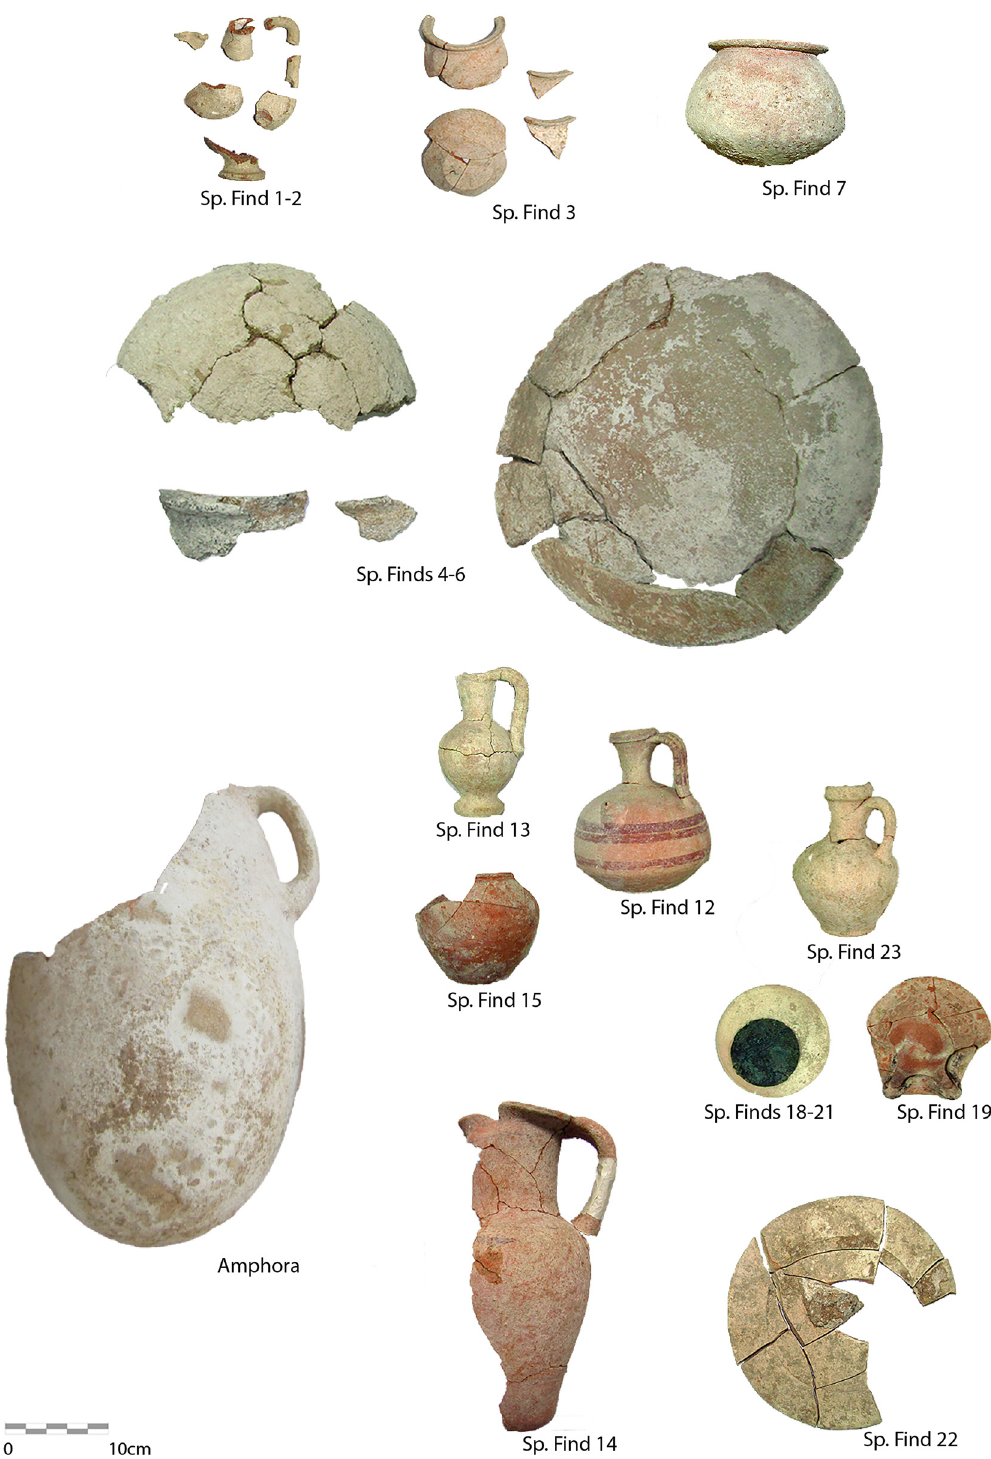
Figure 11: Selected special fi